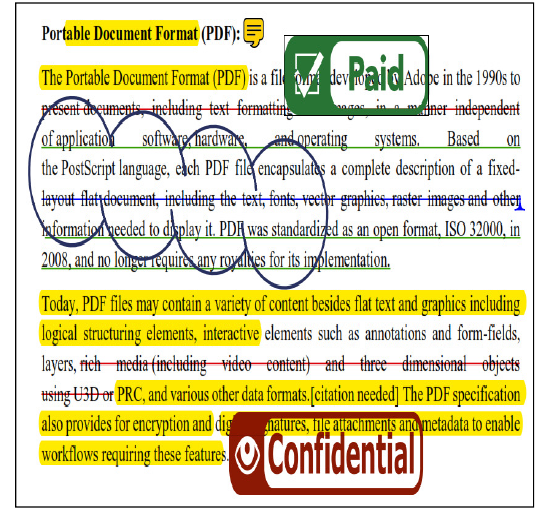
Fig. 9: Applying marks and annotated in a watermarked PDF file using Nitro Pro 8.